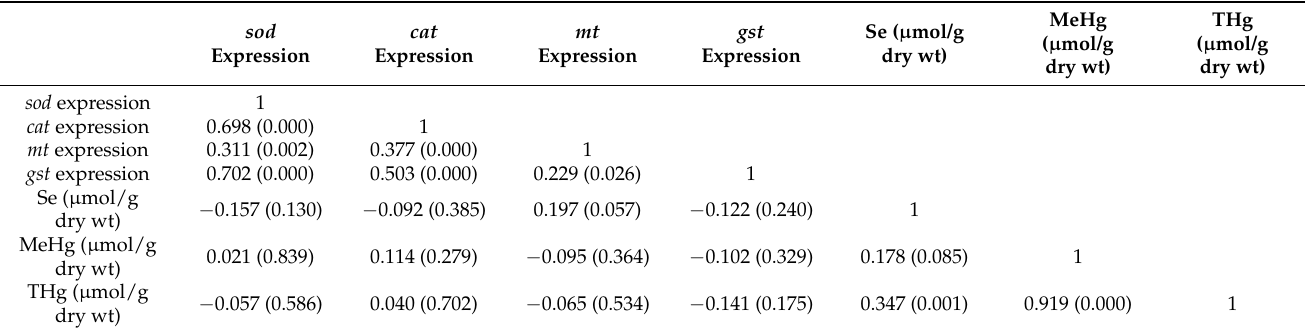
Table 4. Range and mean ( ± SD) values of normalized gene expression in northern pike collected from Isle Royale National Park (ISRO), Pictured Rocks National Lakeshore (PIRO), Sleeping Bear Dunes National Lakeshore (SLBE), and Voyageurs National Park (VOYA). Park